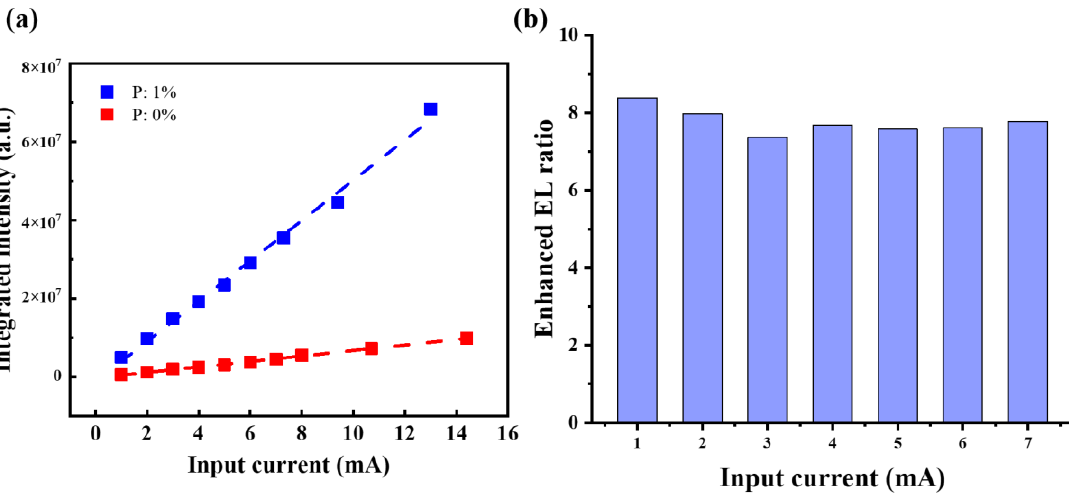
Figure 7. ( a ) Integrated intensity of EL spectra of 0% and 1% P-doped LEDs with various applied currents; ( b ) enhanced EL ratio between 0% and 1% P-doped LEDs with various applied currents.